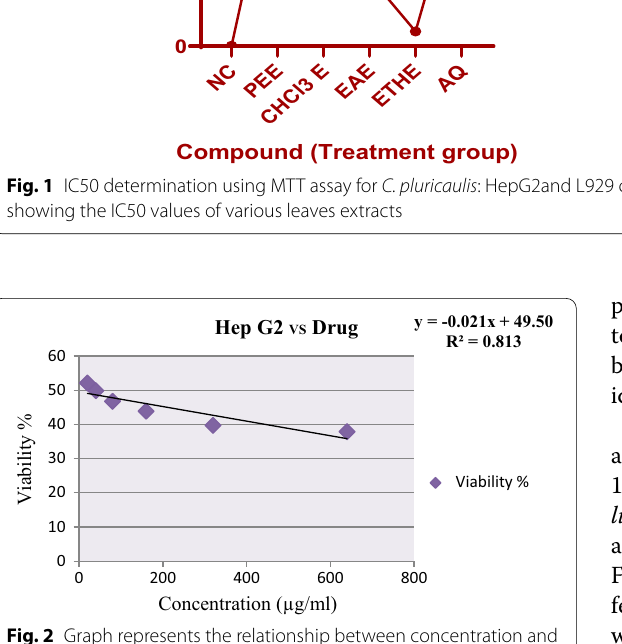
Fig. 2 Graph represents the relationship between concentration and %